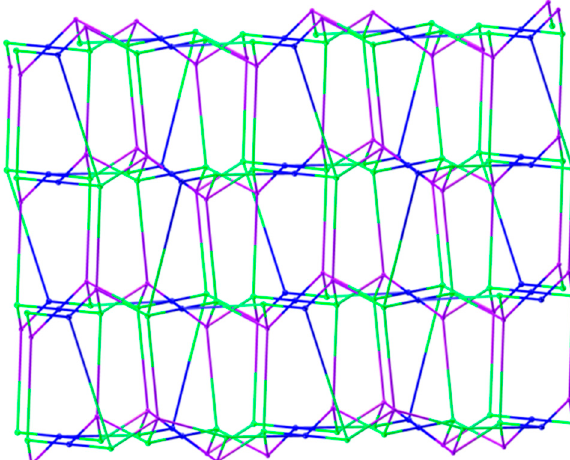
Figure 7. The 3D framework of Polymer 2.